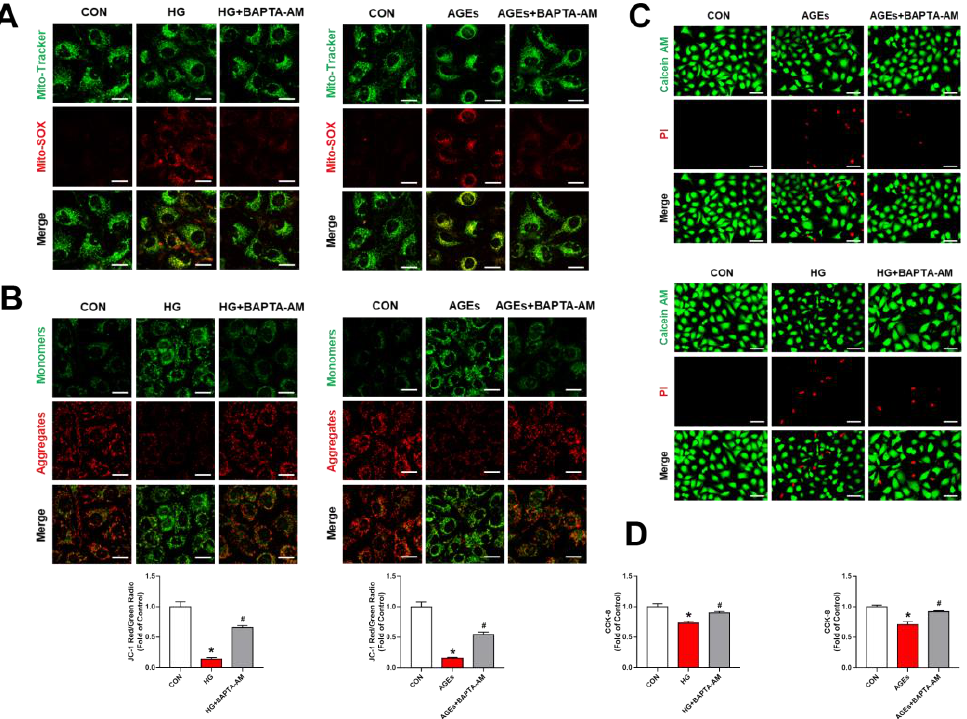
Figure 3. Mitochondria Ca 2+ induced mitochondrial dysfunction and damage in RMECs. RMECs were preconditioned with BAPTA-AM (10 µ M) for 2 h, supplemented by stimulation with HG (33 mM) or AGEs (200 µ g/mL) for 48 h. ( A ) MitoSOX™ Red (5 µ M, 10 min) and Mito-Tracker Green (200 nM, 30 min) were used to co-localize mitochondrial ROS and mitochondria. Scale bars = 25 µ m. ( B ) Mitochondrial membrane potential was assessed by JC-1 staining. Scale bars = 25 µ m. ( C ) Live cells (green, Calcein-AM, 2 µ M, 30 min) and dead cells (red, PI, 5 µ M, 30 min) were detected by a Calcein-AM/PI double staining kit. Scale bars = 25 µ m. ( D ) BAPTA-AM rescued HG or AGE-induced cell damage, as determined by the CCK-8 assay. Data are presented as means ± SD. * p < 0.05 vs. control group, # p < 0.05 vs. HG or AGEs group.